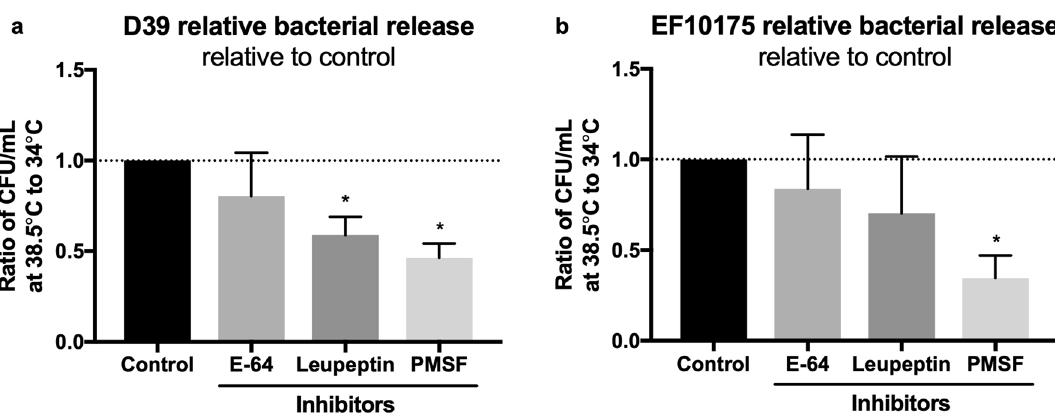
Figure 3. Role of protease activity in heat-induced biofilm dispersal. ( a ) D39 and ( b ) EF10175 biofilms were exposed to protease inhibitors PMSF (20 μM), leupeptin (10 μM), or E-64 (10 μM) at 34 °C or 38.5 °C for 4 h. Supernatants containing the released bacteria were enumerated by viable plate counts. The relative bacterial release is shown as a ratio of the CFU/ml at 38.5 °C compared to 34 °C and then normalized to the control without inhibitor. For reference, the average bacterial release for the control was approximately 6.5 × 10 7 CFU/ ml for D39 and 9.7 × 10 7 CFU/ml for EF10175, which was 3.6 times or 2.8 times higher than the release at 34 °C, respectively. Data represent triplicates from four separate experiments, with the mean and SEM displayed. Statistical analysis was performed using Mann–Whitney U test by comparing to the control; * P < ously exposed to the nasopharyngeal temperature of 34 °C with or without indicated proteases for 2 h (Fig. 2). The serine proteases trypsin and proteinase K as well as the cysteine protease papain increased pneumococcal release from biofilms formed by both the laboratory strain D39 and the clinical isolate EF10175 (Fig. 2), indicat- ing that extracellular proteases can cause release of pneumococci from biofilms. As exposure to the febrile temperature of 38.5 °C resulted in a phenotypic change representative of other disease triggers in dispersed bacteria 11,13 , we next investigated the role of protease activity in heat-induced dispersal. Biofilms were exposed to 38.5 °C for 4 h or continually exposed to 34 °C in the presence or absence of protease inhibitors and bacterial release into the supernatant was determined by viable plate counts (Fig. 3). In biofilms formed by strain D39, presence of either serine protease inhibitors PMSF or leupeptin significantly reduced heat-induced dispersal as compared to control biofilms, whereas presence of the cysteine protease inhibitor E-64 did not have any significant effect (Fig. 3a). Similar results were observed in biofilms formed by the strain EF10175, although a significant decrease in heat-induced dispersal was only seen in the presence of PMSF (Fig. 3b). Interestingly, passive bacterial release as part of normal turnover of bacterial biofilms at 34 °C was not inhibited by exposure to protease inhibitors (data not shown), suggesting a different mechanism of release.